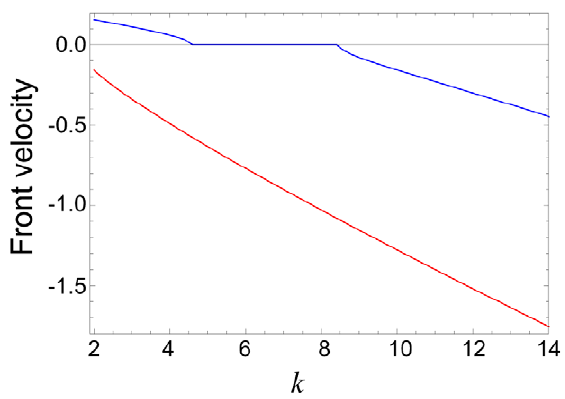
Figure 10. Dependence of the front velocity on node degree. The blue curve corresponds to the first kind of fronts, shown in Fig. 9A; the red curve is for the second kind of fronts shown in Fig. 9B. The diffusion constant is D ~ 0 : 1 ; the other parameters are r 1 ~ 1, r 2 ~ 1 : 4 and r 3 ~ 3 .